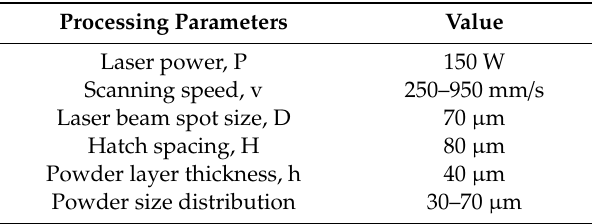
Table 2. SLM processing